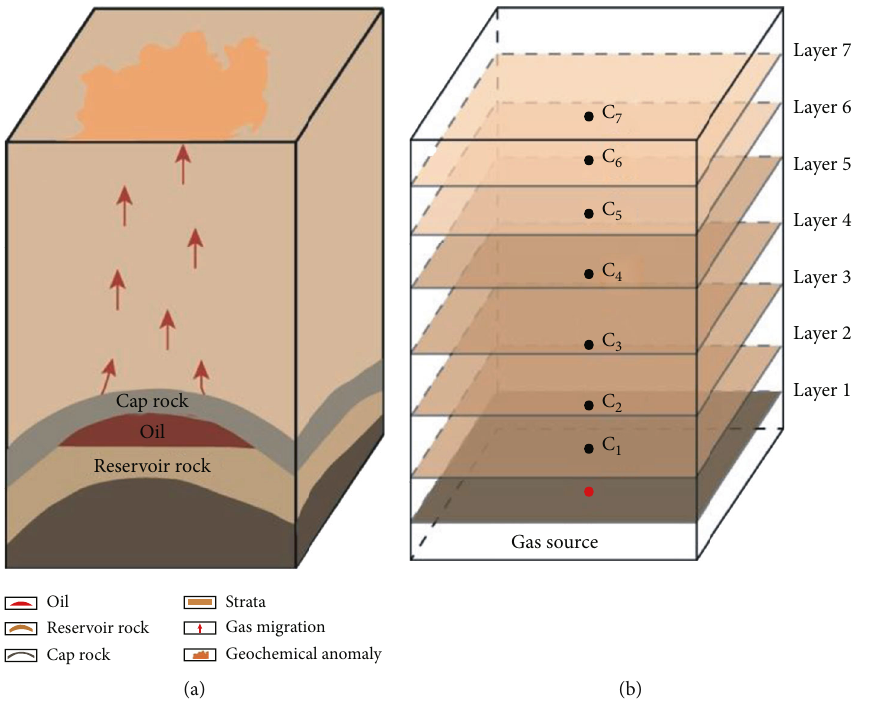
Figure 3: (a) Microseepage CH vertical migration concept model. (b) Sketch of delineation of 4